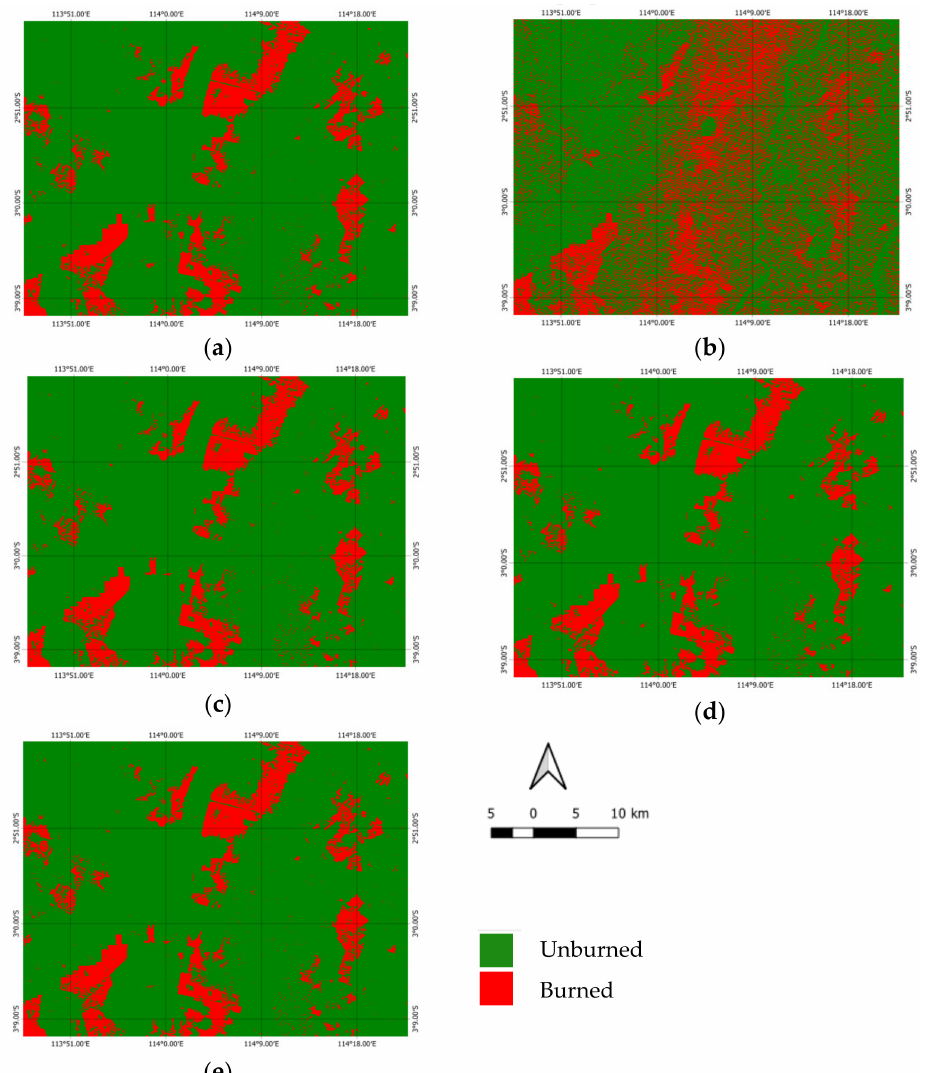
Figure 13. The classification results using the CNN-RF method in the Schemes: ( a ) #1; ( b ) #2; ( c ) #3; ( d ) #4; and ( e )